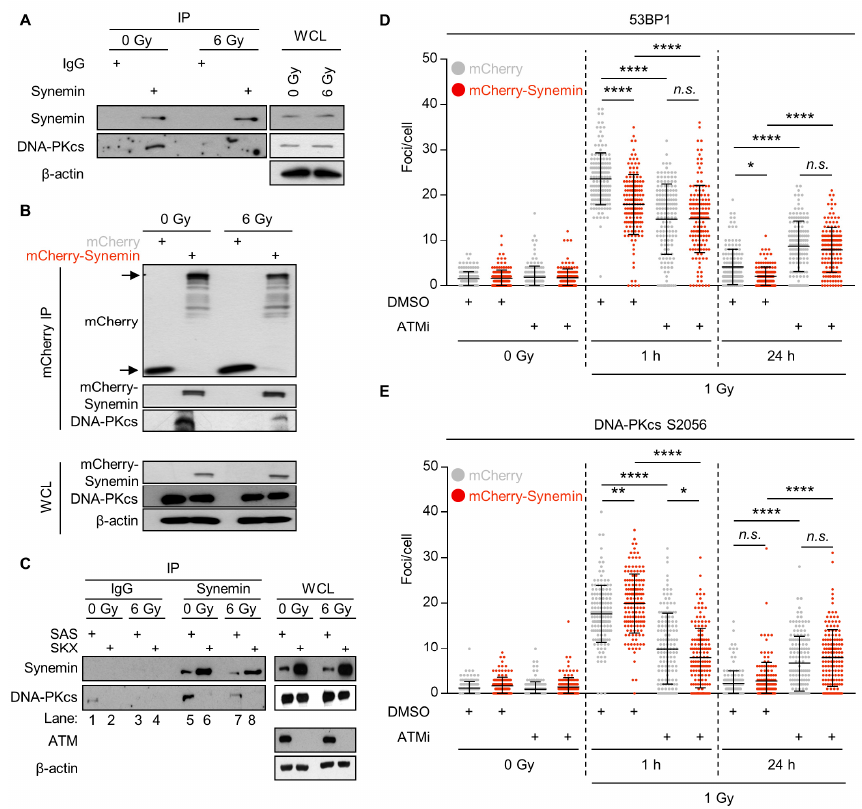
Figure 5. DNA-PKcs directly interacts with synemin and depends on ATM activity. ( A ) Immunoprecipitation (IP) of Synemin 1 h post 6-Gy X-rays. Western blot analysis showing expression of Synemin and DNA-PKcs in immunoprecipiates and whole cell lysates (WCL) from SAS cells; ( B ) Western blot on mCherry immunoprecipitates from 6-Gy irradiated mCherry-SAS and mCherry–Synemin-SAS cells at 1 h post irradiation. β -actin served as loading control; ( C ) Western blots on synemin immunoprecipitates from SAS and SKX cells 1 h after 6-Gy X-ray exposure; ( D , E ) 53BP1 and DNA-PKcs S2056 foci upon ATMi treatment (DMSO used as control) at different time points post 1-